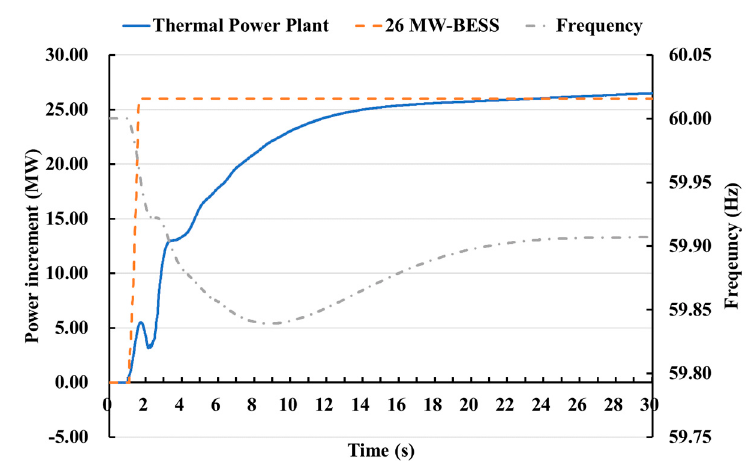
Figure 8. Modeling the BESS using the CBEST model in PSS/E.